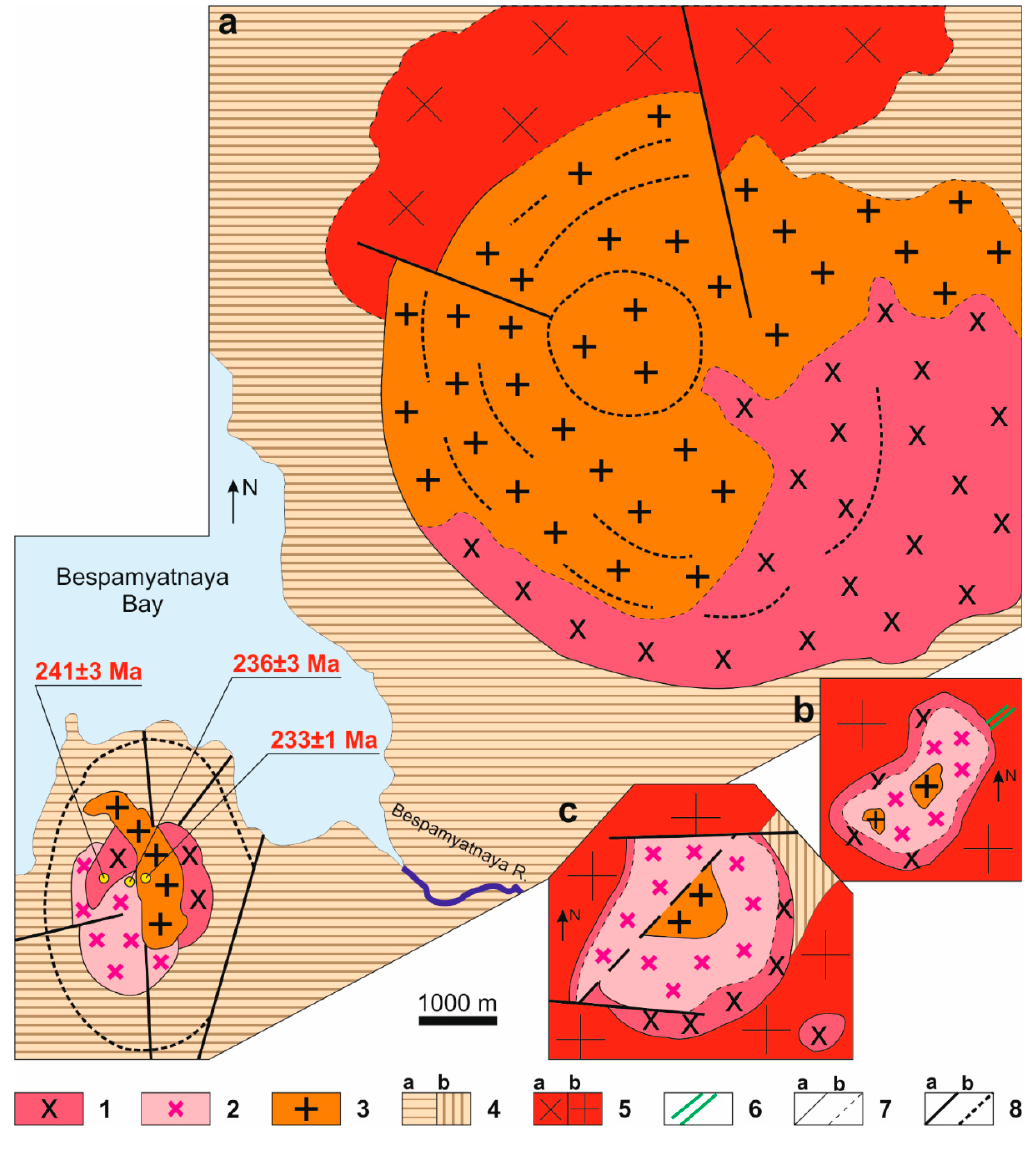
Figure 6. Geological schemes for early Mesozoic ring intrusions in the Northern Domain: ( a ) in the mouth of Bespamyatnaya River; ( b ) in the Kamenistaya and Volchya rivers interfluve; ( c ) in the upper reaches of Kuropatochya River, modified from [56]. 1–3—Middle–Late Triassic stocks: 1— monzogabbro, monzodiorite, monzonite and monzonite-porphyry (241 ± 3 Ma), 2—syenite, monzonite, syenite-porphyry and syenite-aplite (236 ± 3 Ma), 3—quartz syenite, quartz syenite-